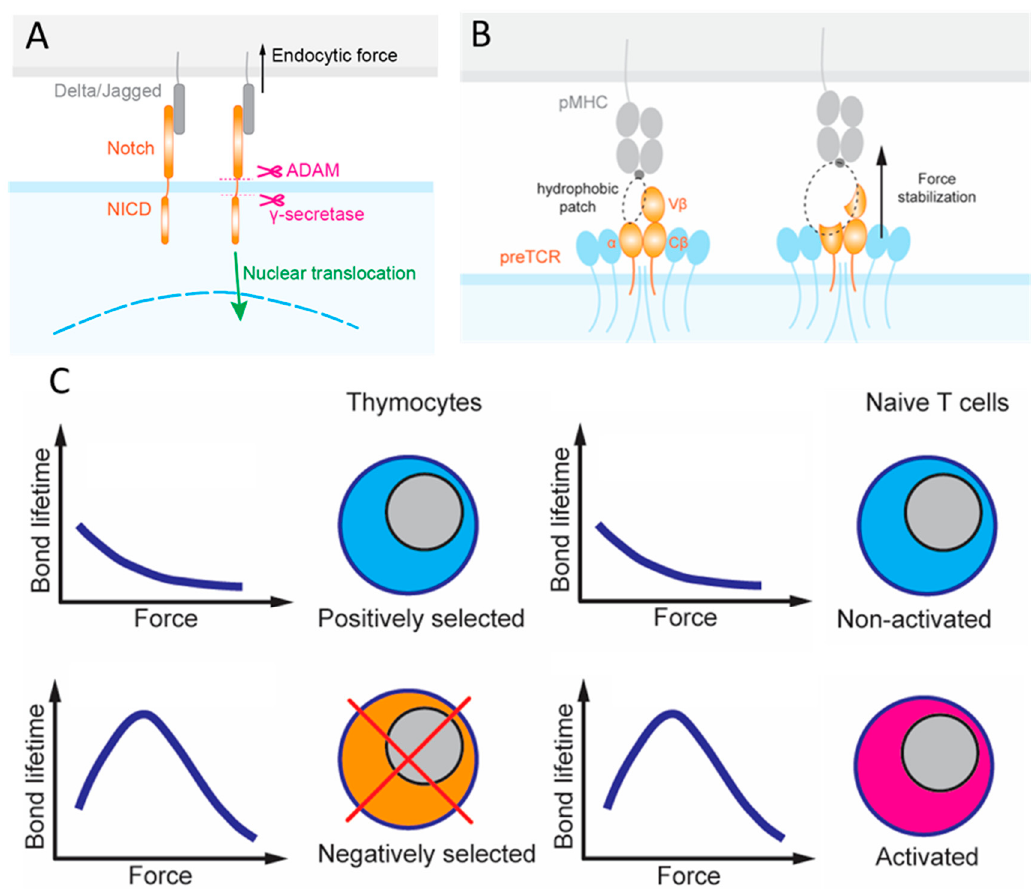
Figure 2. Forces induce di ff erential outcomes at di ff erent T cell development stages. Schematic depicting four developmental stages of T cells and how receptors experience force. ( A ) Notch receptor undergoes force induced conformational changes to reveal cryptic sites for proteolytic cleavage by γ -secretase and a disintegrin and metalloprotease (ADAM) allowing for nuclear translocation of the Notch intracellular domain (NICD). ( B ) A hydrophobic patch created by V β and pT α allows for broad pMHC binding and is potentially force stabilized by the FG-loop of C β . ( C ) Similar to thymocyte selection, which relies on dynamic catch bonds to discriminate between positive and negative selection ligands, dynamic bonds can facilitate discrimination between the antigens that are stimulatory or non-stimulatory.